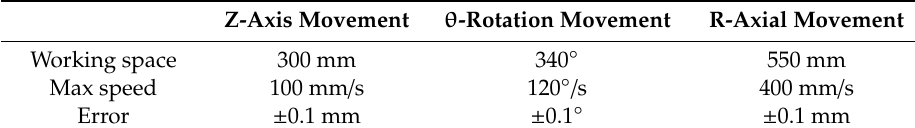
Table 4. Technical specifications of proposed design.